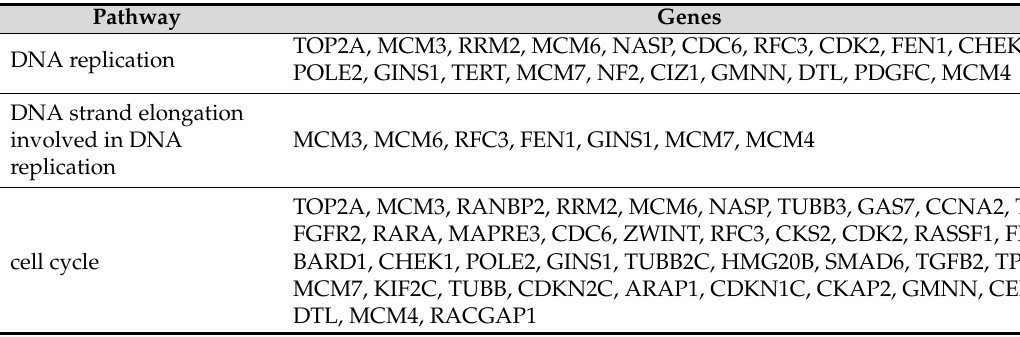
Table 4. Pathways/processes that were significantly over represented after immortalisation, that is were up-regulated in hTERT cells (i.e., only those associated with cell proliferation [Cell Cycle, Mitosis and DNA Replication] or telomere maintenance were